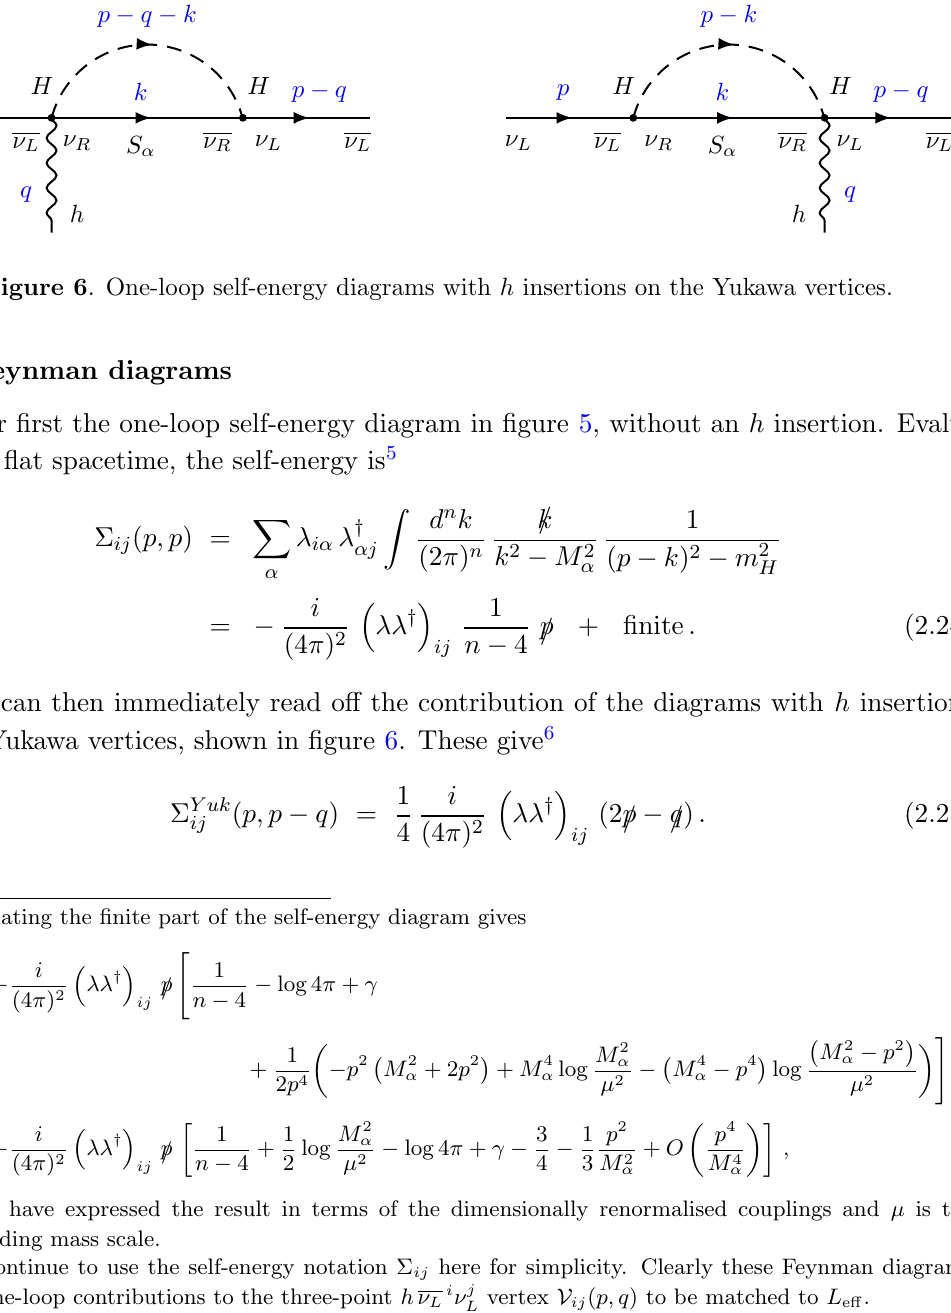
Figure 5 . One-loop self-energy diagram for the light neutrinos in (cid:13)at spacetime.